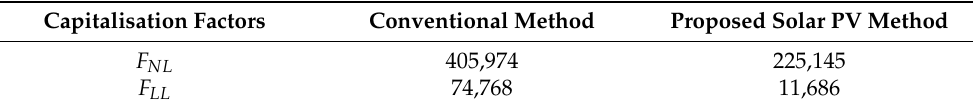
Table 2. Capitalisation of losses: proposed method (Equations (9) and (10)) vs. conventional (Equa- tions (4) and (5)).